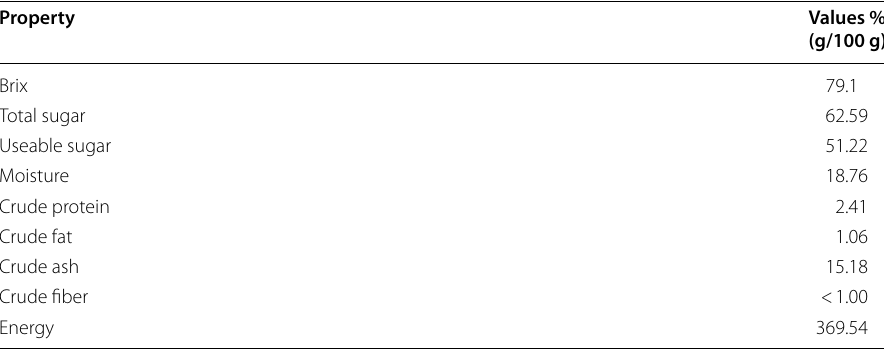
Table 1 Proximate analysis results of raw cane molasses